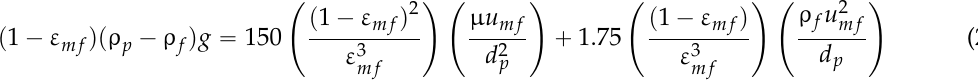
a a gD and u mf { gD for the two